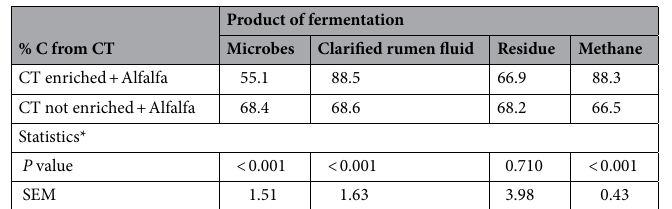
Table 3. Contribution of carbon from condensed tannins (CT) in enriched or not-enriched mixed substrates from in vitro fermentation from Trial 2. *Means are considered different when P < 0.05.